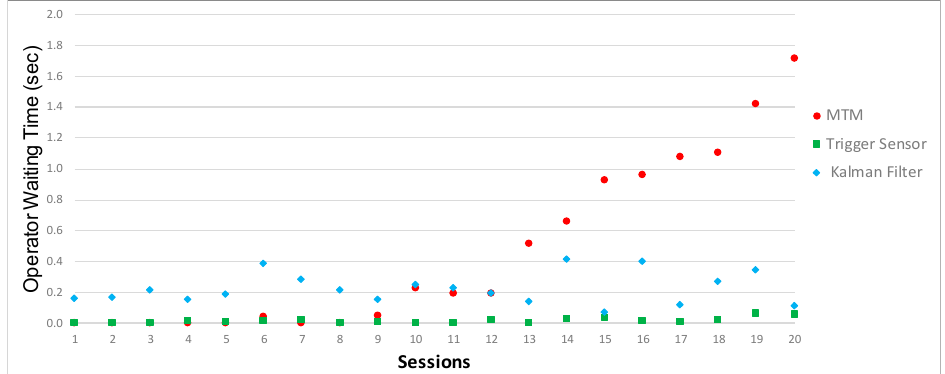
Figure 13. Time variation of the OWT for different handover prediction models under the assembly learning effect.